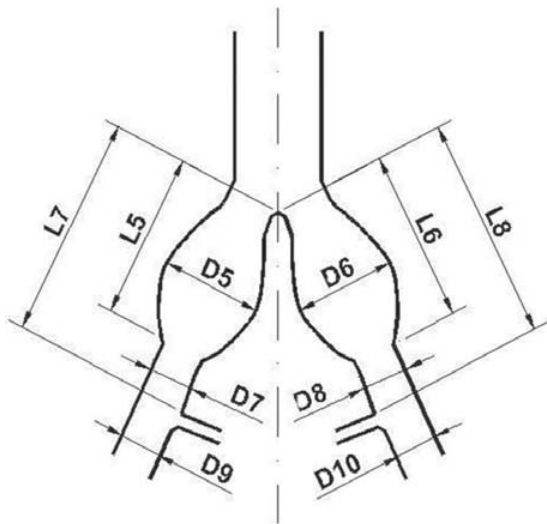
Fig. 2 - Diâmetros(D) e extensões(L) distais ilíacas